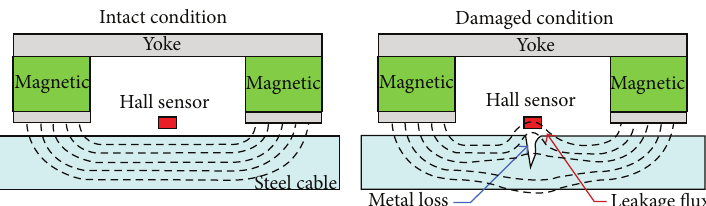
Figure 6: Mechanism of MFL-based damage detection